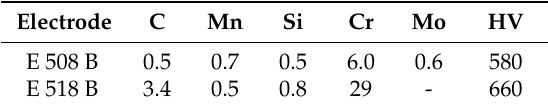
Table 1. Chemical composition and hardness of welding electrodes in wt.